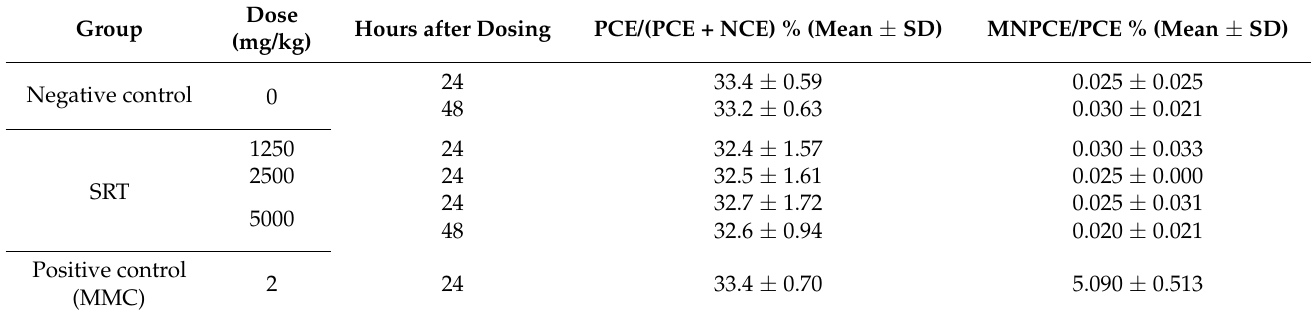
Table 2. Results of micronucleus assays in male ICR